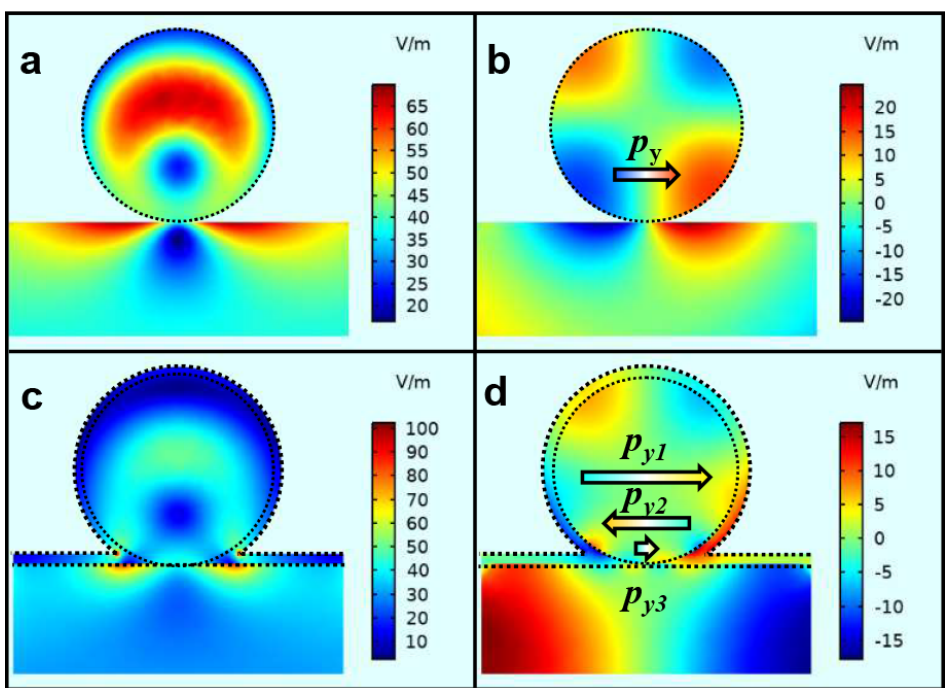
Figure 6. The simulated electric field distribution images. Distributions of electric field ( a ) and z component of electric field ( b ) of the Si NS on glass substrate in YZ plane at the wavelength of 612 nm. Distributions of electric field ( c ) and z component of electric field ( d ) of the system-1 in YZ plane at the same wavelength.